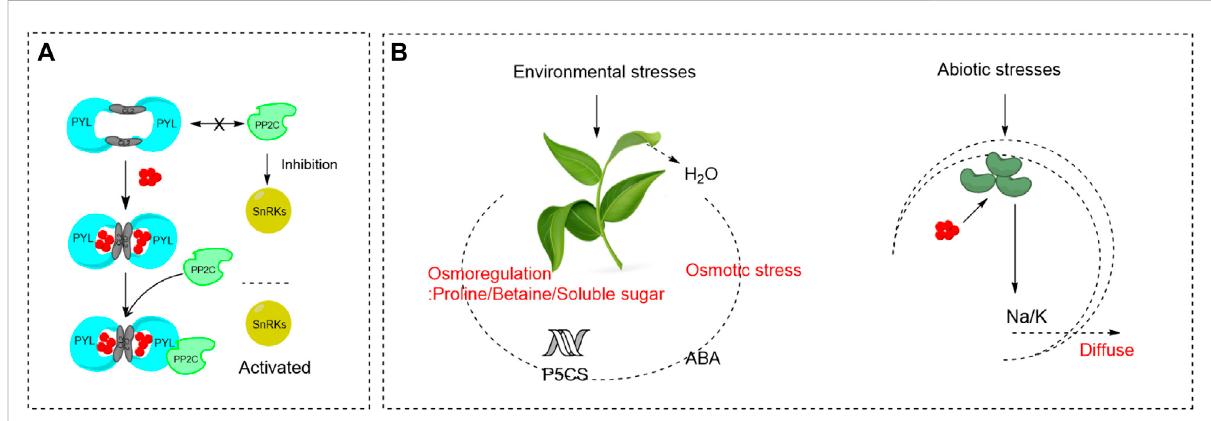
FIGURE 2 ABAsignaltransductionandtheroleofABApathwaysinstresssignaling (A) TheworkingmodelofABA-dependentrecognitionandinhibitionof PP2Cs by PYLs (Cutler et al., 2010; Soon et al., 2012). (B) The role of abscisic acid pathways in stress signaling (Shinozaki and Yamaguchi-Shinozaki, 2000; Finkelstein et al.,